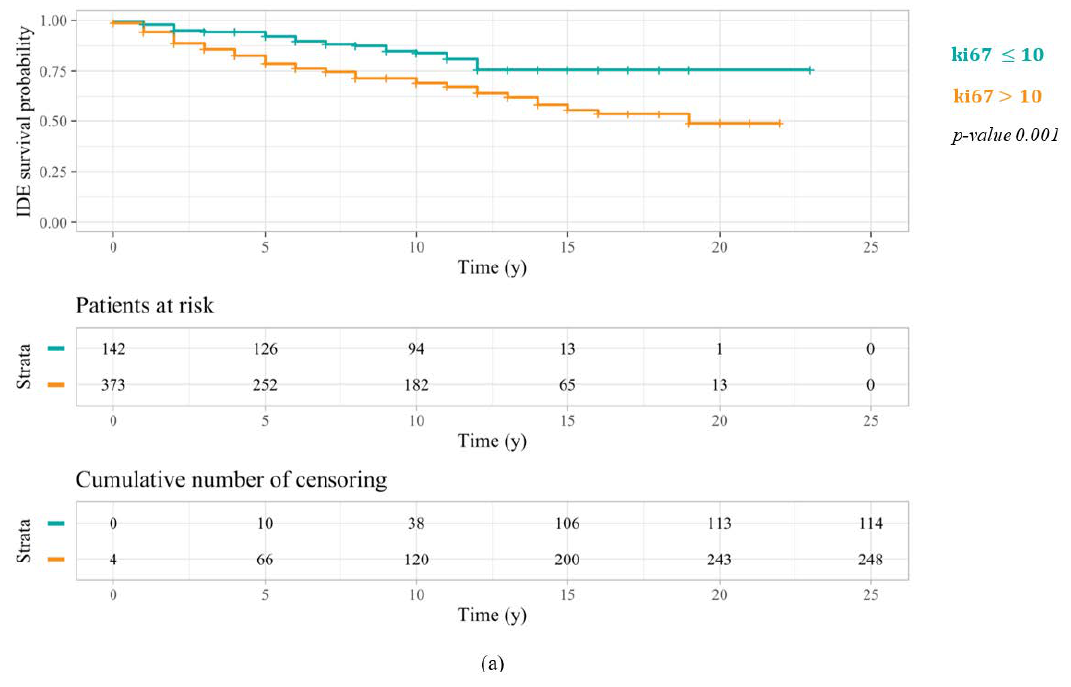
Figure 1. IDEFS curves related to a Kaplan – Meier analysis performed on patients under 50 years old with respect to the three different ki67 threshold values: 10% ( a ), 14% ( b ), and 20% ( c ). The log- rank test p -values highlighted a greater significance of the first